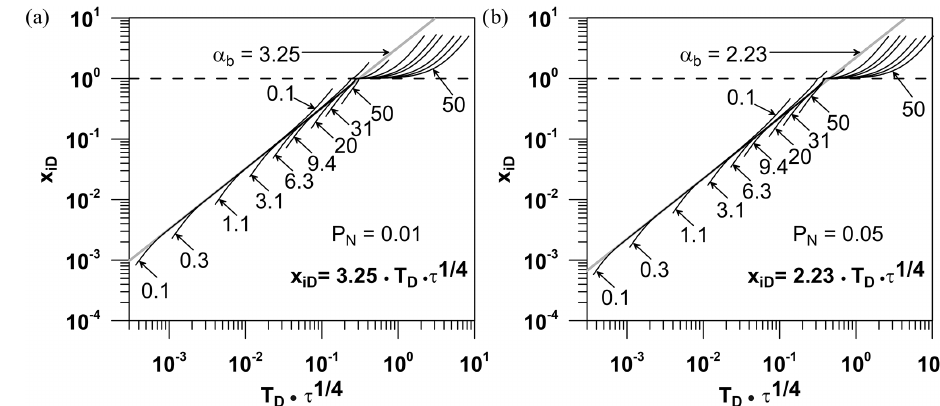
Figure 5. Model results in terms of x iD vs. T D · τ 1 / 4 on a log–log scale. Propagation of isobars P N along the fracture considering the following dimensionless fracture conductivities: T D = 0 . 1, 0 . 3, 1 . 1, 3 . 1, 6 . 3, 9 . 4, 20, 31, and 50. (a) Model scenarios with P N = 0 . 01 and α b = 3 . 25; (b) model scenarios with P N = 0 . 05 and α b = 2 . 23. The dashed lines represent the arrival at the fracture tip of the specific isobars indicated in the graphs.